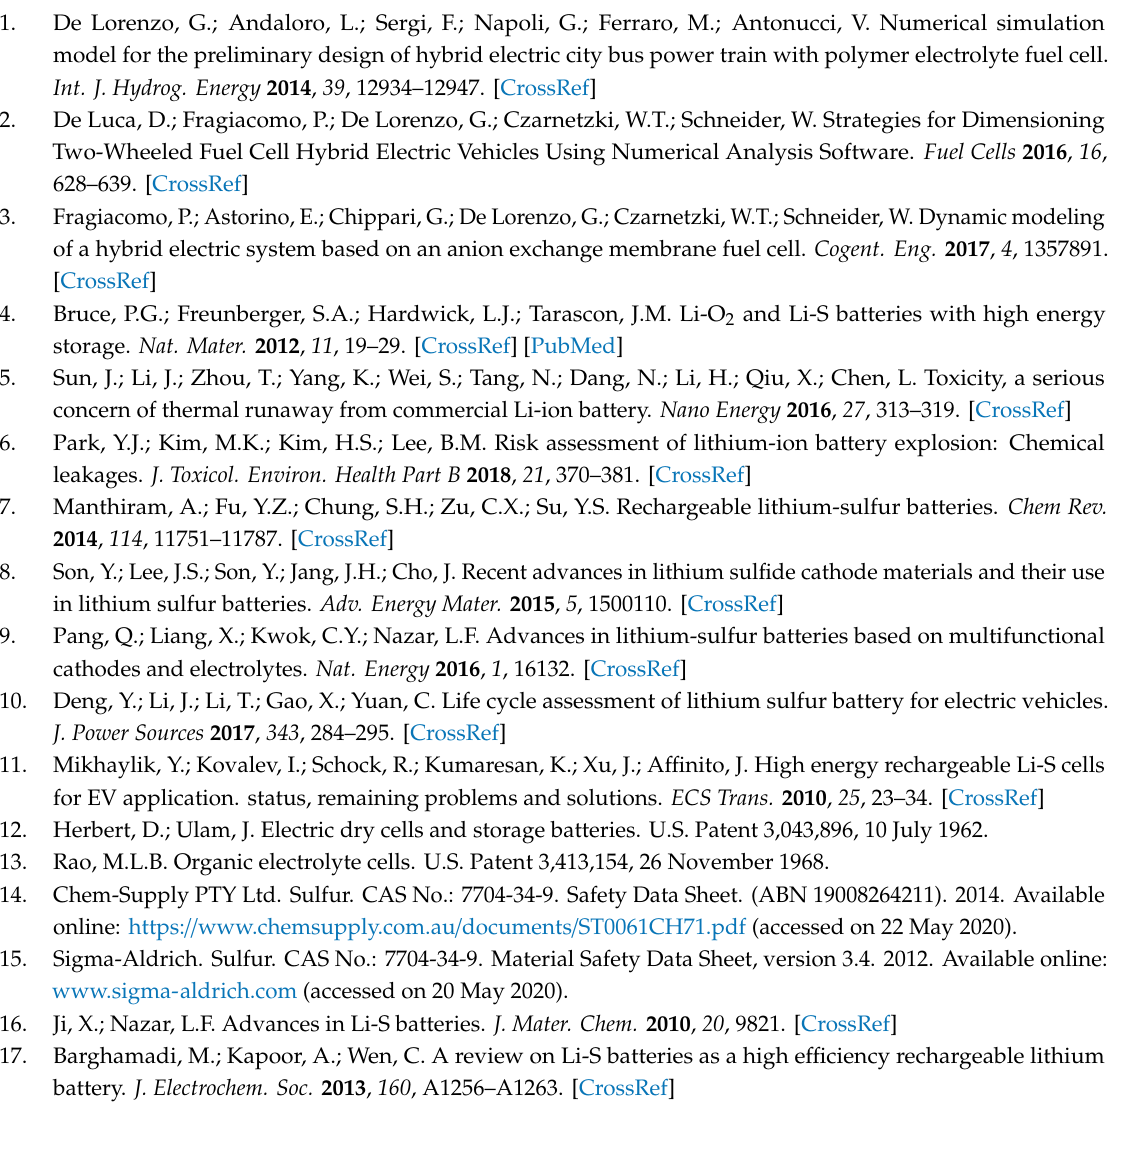
Table 16. Suggestions for the least toxic materials used for the main components of Li-S cell. Li-S Cell Comments Material Component Gelatin Binder Practically non-toxic Celgrad Separator Practically non-toxic Electrolyte Ionic conducting solid materials are the least electrolytes Lithium protected by DOL layer Anode Protecting layer limits the toxicity of pure lithium C is much lower toxic than S. The content of S should be Carbon + Sulfur Cathode limited to the necessary